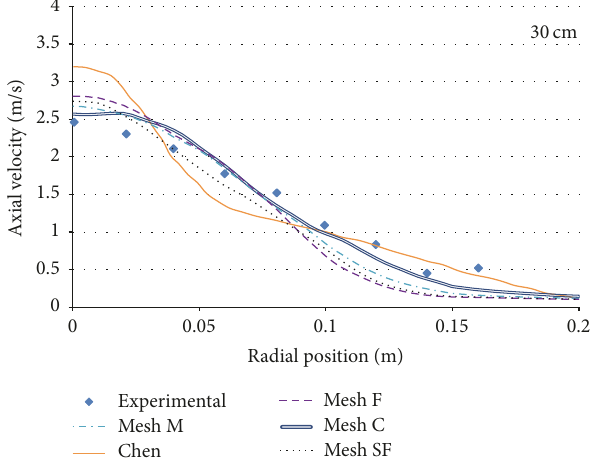
Figure 12: Radial position versus axial velocity 10cm from the burner exit.